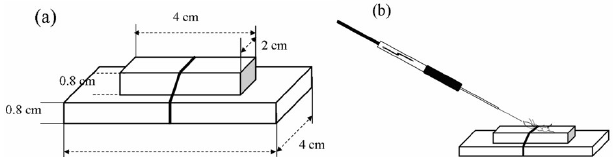
Fig 2. Device used for ant immobilization (a) before SPME venom extraction